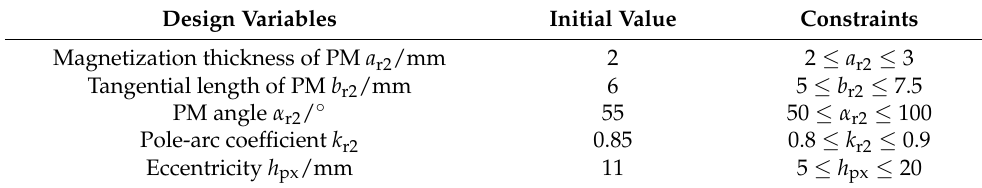
Table 5. The constraint scope of the design